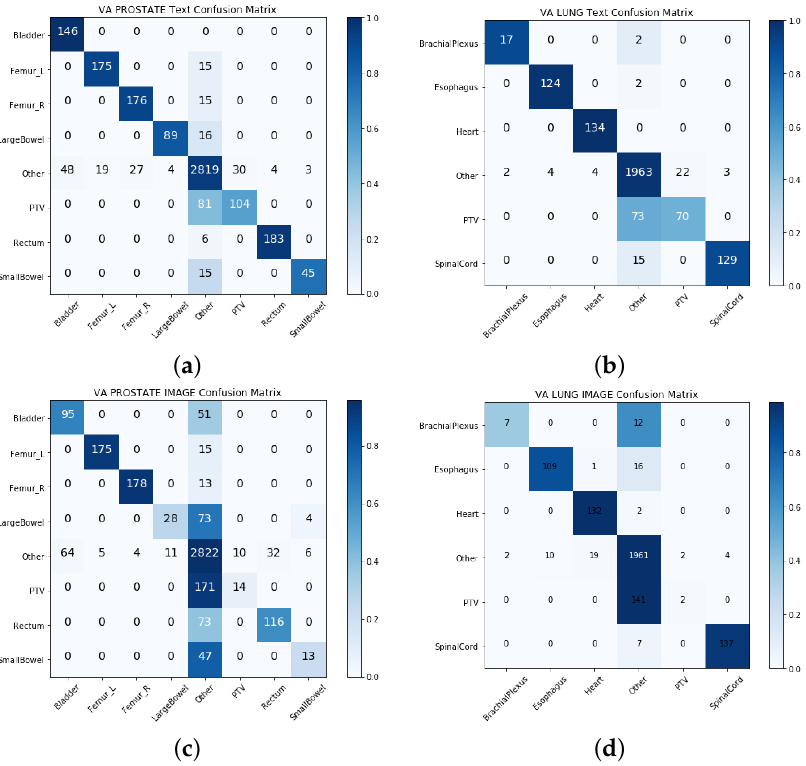
Figure 3. Single-view results: ( a ) VA-ROQS prostate text-based features. ( b ) VA-ROQS lung text- based features. ( c ) VCU prostate image features. ( d ) VCU lung image features. A darker color demonstrates more accurate prediction, and the diagonal shows the labels predicted